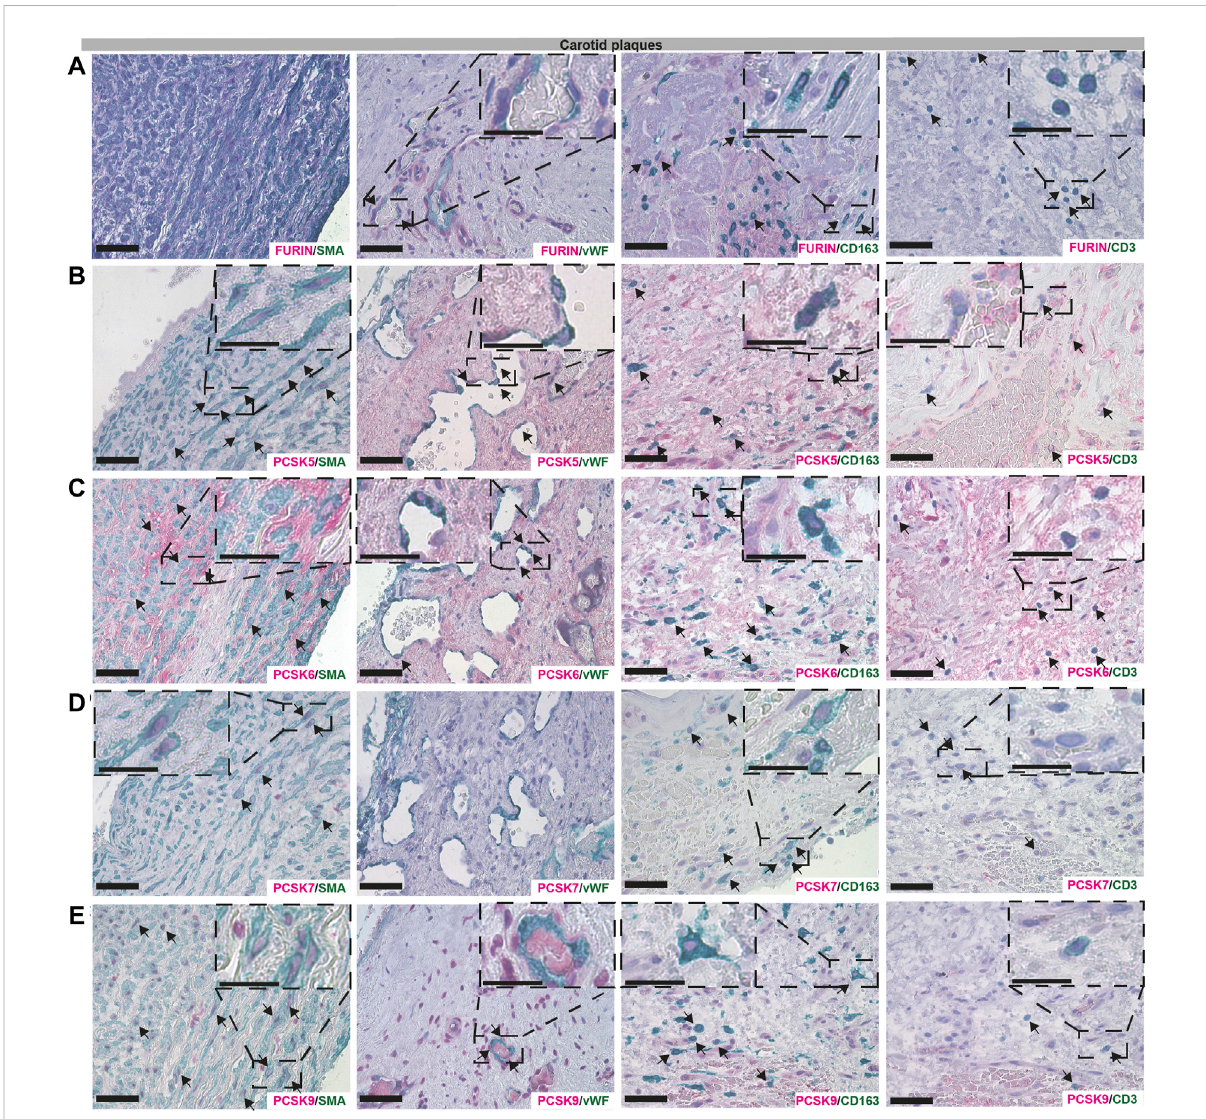
FIGURE 6 Co-localisationofFURIN,PCSK5-7andPCSK9withmajorcelltypesincarotidplaques.Immunohistochemistryco-stainingsofclassicalmarkers CD3 (T cells), CD163 (macrophages), SMA (smooth muscle cells) and vWF (endothelial cells) with FURIN (A) , PCSK5 (B) , PCSK6 (C) , PCSK7 (D) and PCSK9 (E) . Scale bar represents 50 μ m and in the enlarged insets 25 μ